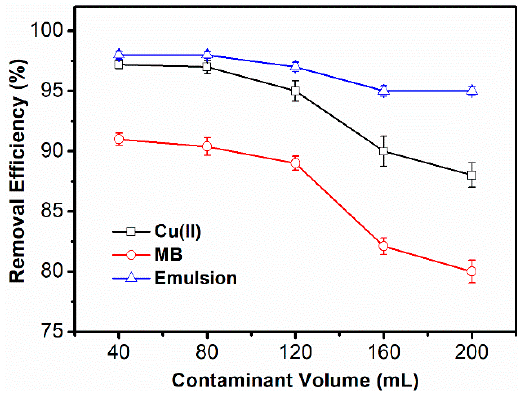
Figure 13. Effect of solution volume on the removal ability of MB, Cu(II) and emulsion.